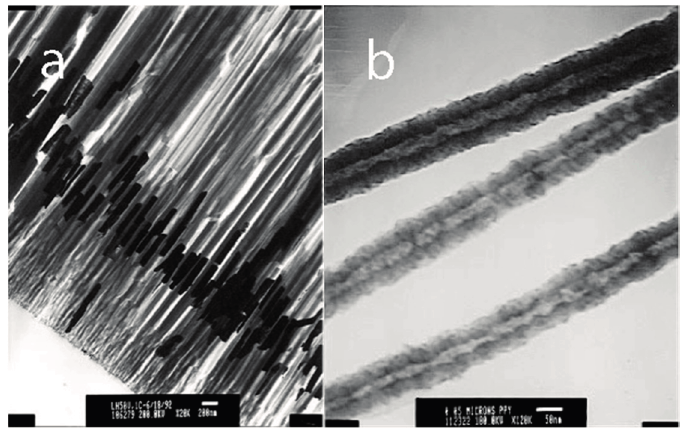
Figure 5. ( a ) Transmission electron micrograph (TEM) of a microtomed section of an alumina template membrane showing 70 nm diameter Au nanofibrils within the pores; ( b ) Transmission electron micrograph of three polypyrrole nanotubules. The outside diameter is ~90 nm; the inside diameter is ~20–30 nm. Adapted with permission from [61], Copyright © 1996 American Chemical